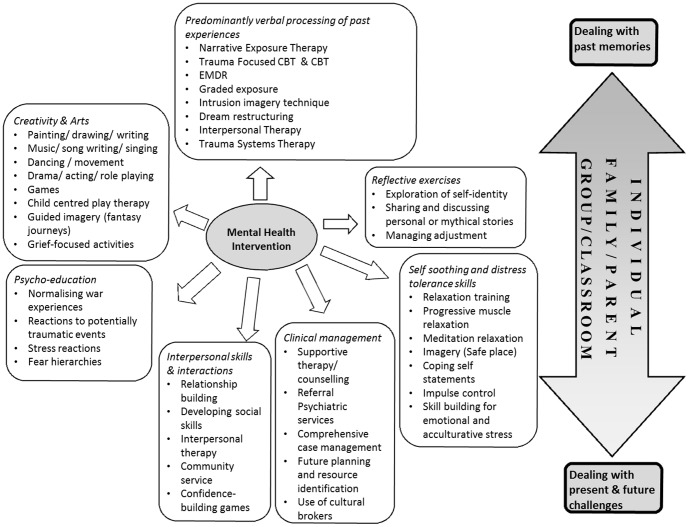
Diagram to show the range of mental health interventions included in the selected studies.